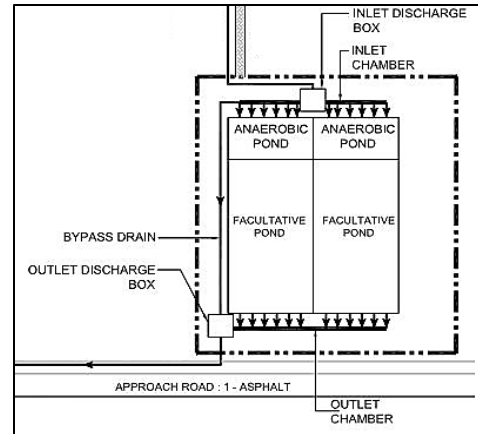
Figure 1: Layout of Wastewater Treatment